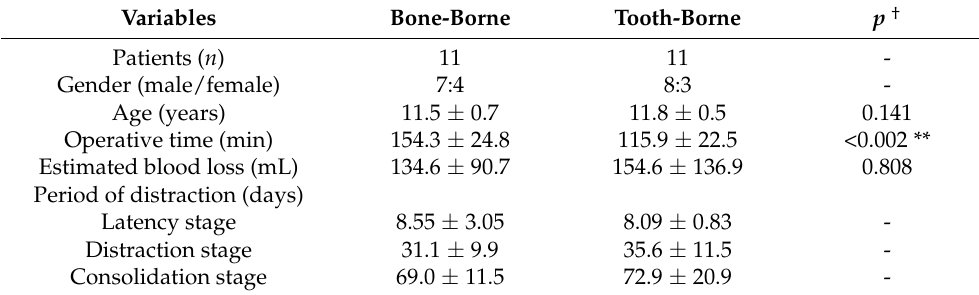
Table 2. Characteristics of the CL/P patients in the bone-borne RED group and the traditional tooth-borne RED